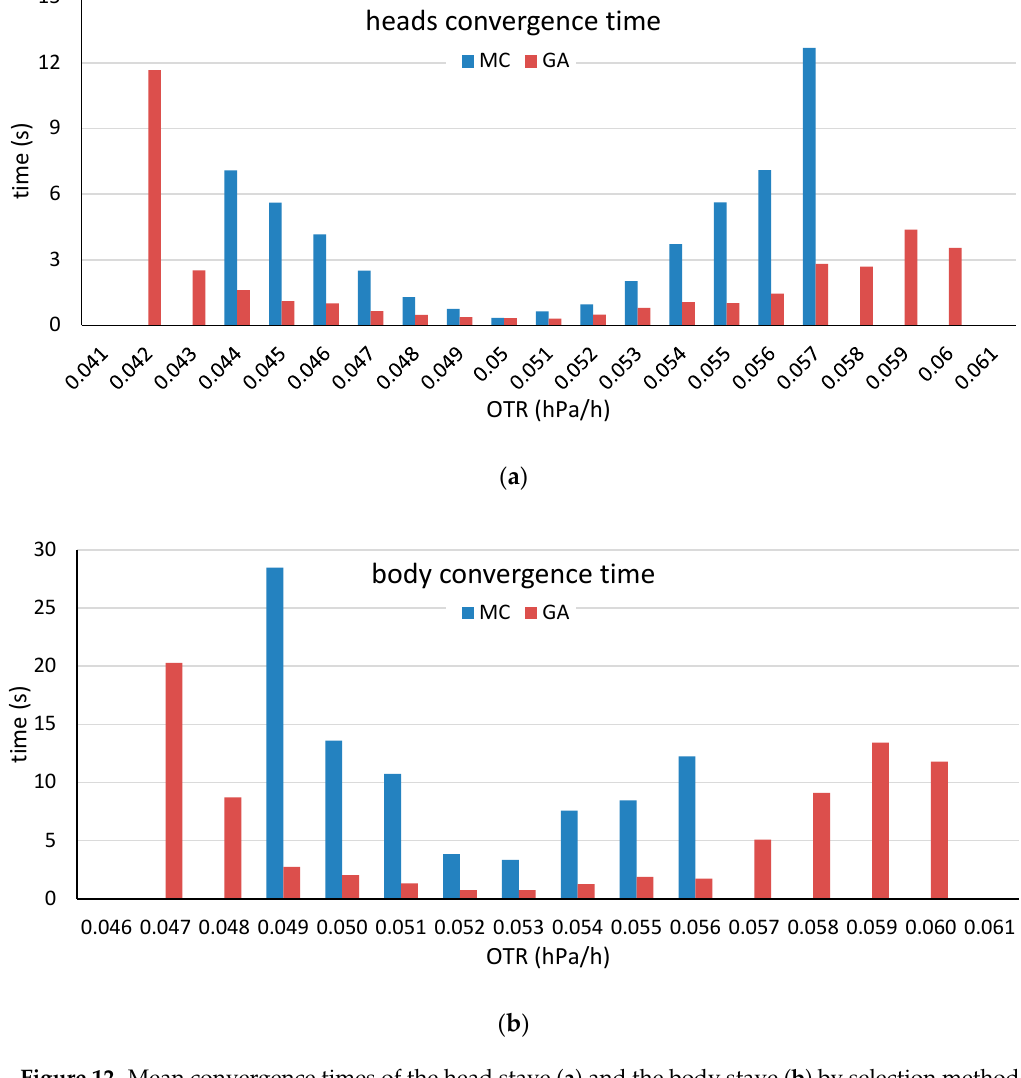
Figure 12. Mean convergence times of the head stave ( a ) and the body stave ( b ) by selection method for various target OTR values obtained by using the head and body high-OTR staves. The mean time was calculated in consideration of only the heads and bodies that were constructed before reaching the maximum iteration time.